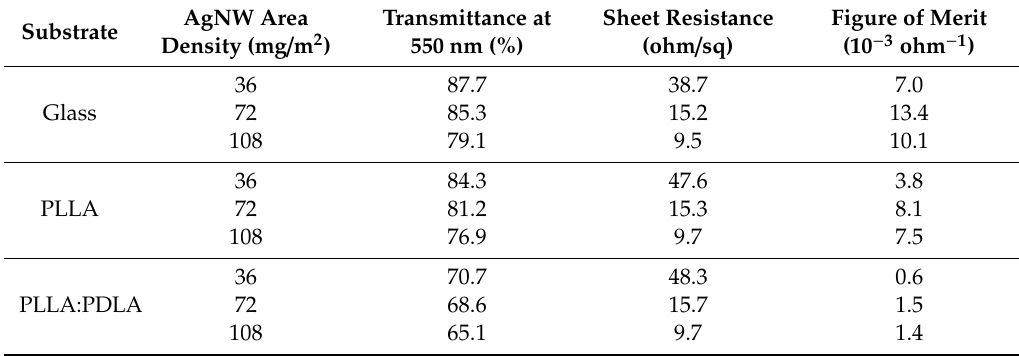
Table 1. Comparison of optical transmittance, sheet resistance, and figure of merit of the AgNW / Glass, AgNW / PLLA, and AgNW / PLLA:PDLA films at di ff erent AgNW area densities. AgNW Area Transmittance at Sheet Resistance Figure of Merit Substrate Density (mg / m 2 ) 550 nm (%) (ohm / sq) (10 − 3 ohm − 1 ) 36 87.7 38.7 7.0 Glass 72